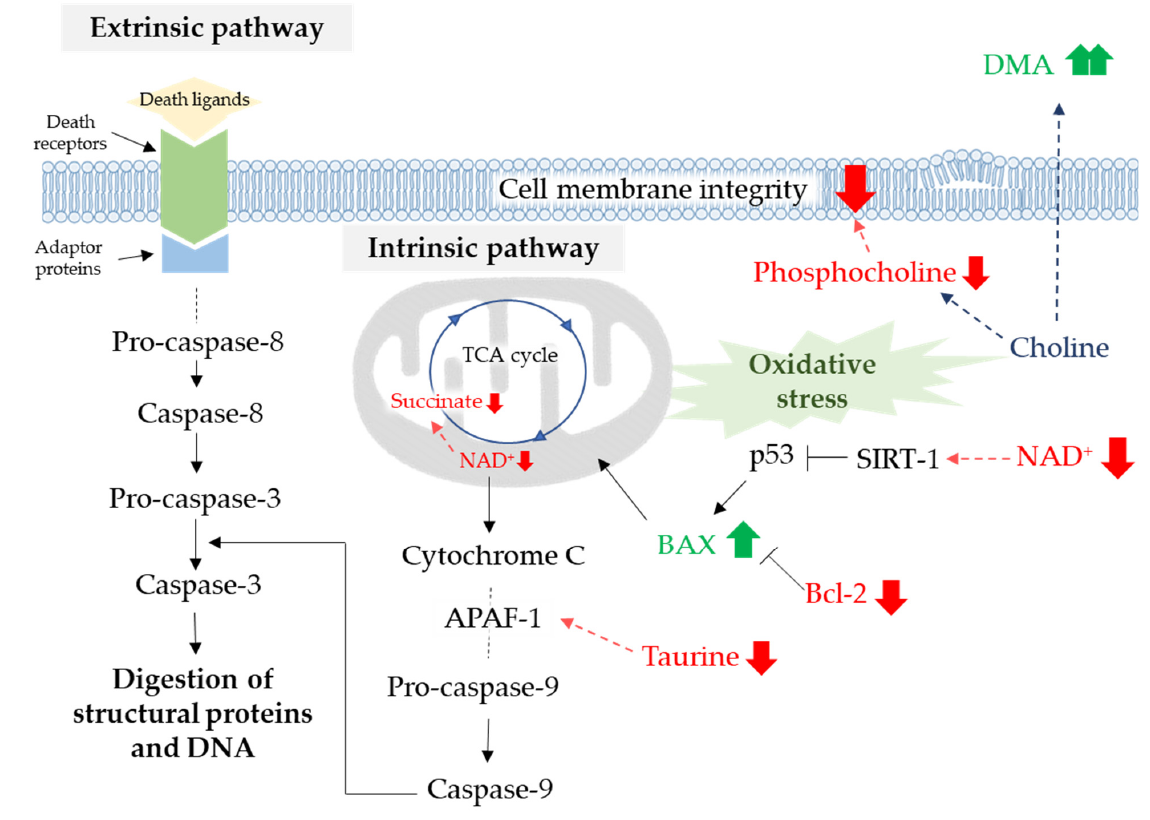
Figure 8. The apoptotic pathways and their relevant metabolites. The red arrow represents a decreased level and the green arrow an increased level compared to the control.